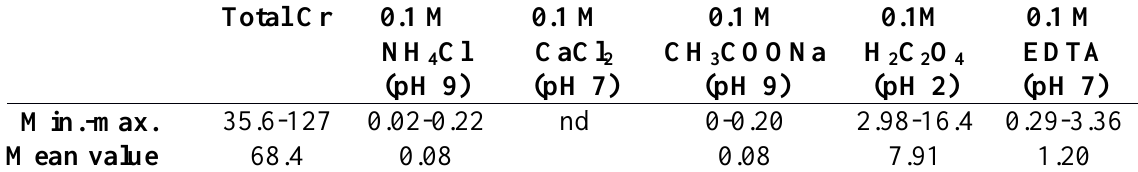
Table 3. Concentration of Cr (mg/kg) extracted by various